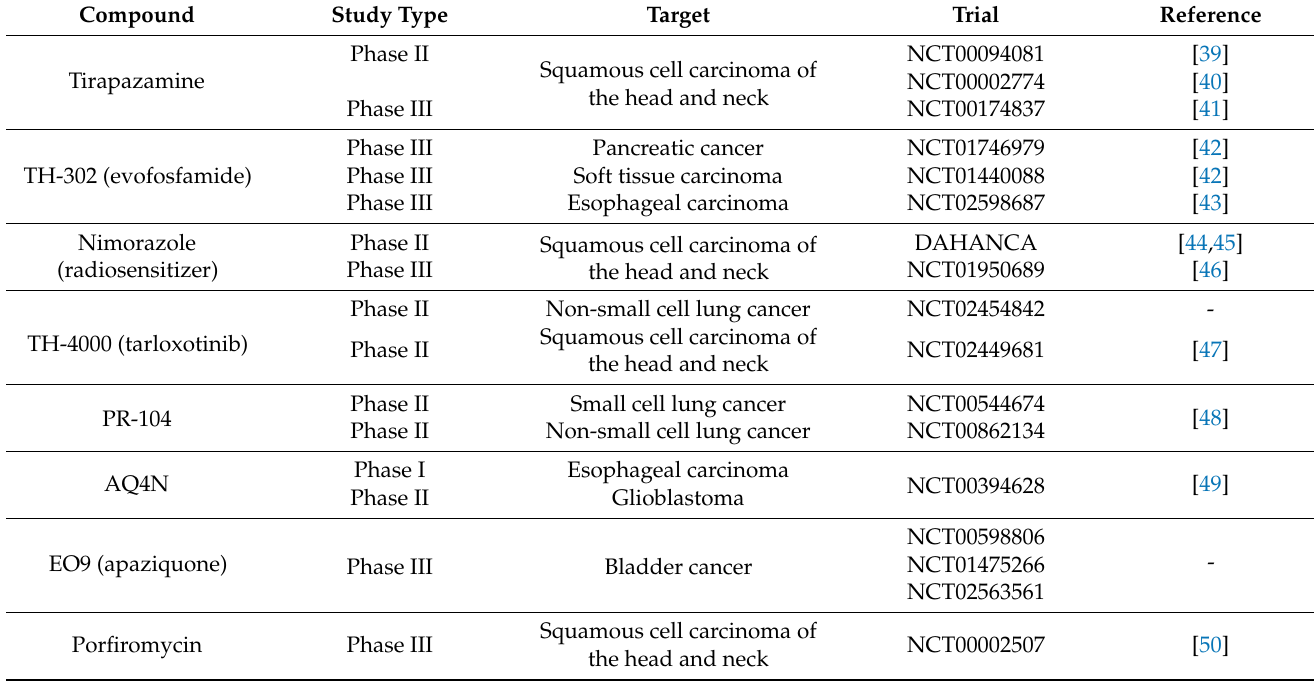
Table 1. Summary of clinical studies of HAPs (based on ref